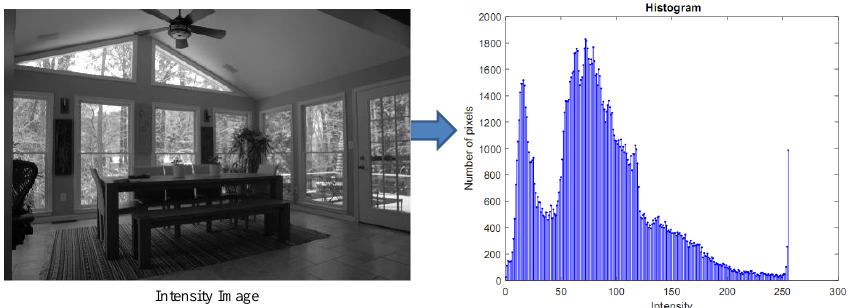
Figure 4. The intensity LDR image and the associated histogram.